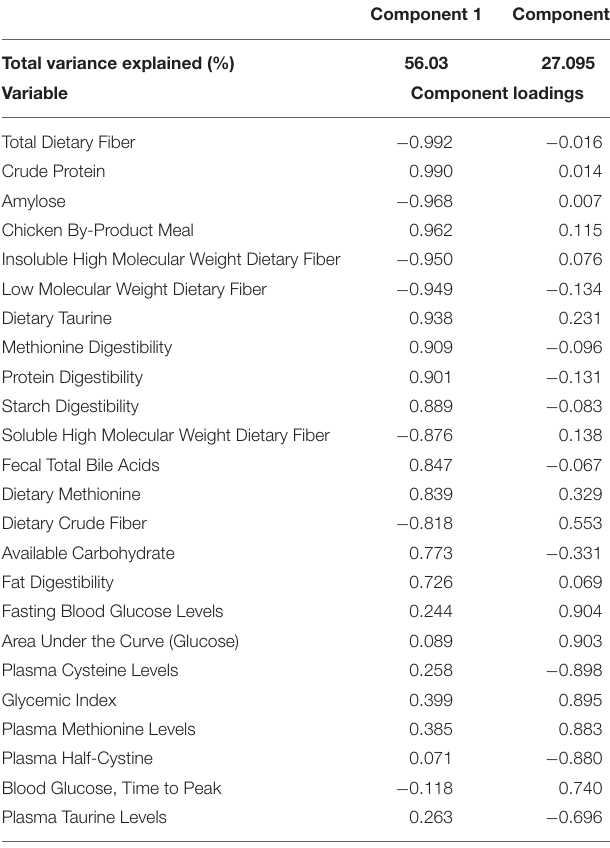
TABLE 7 | Principal Components Analysis of the top 24 variables examined in this study that explained 83% of the variation among